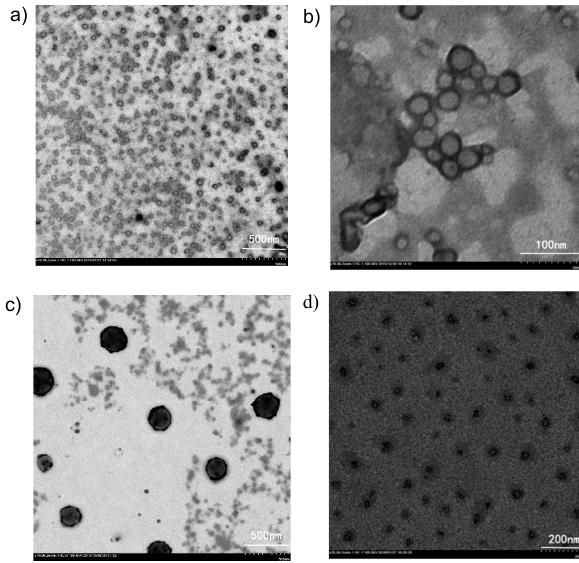
Figure 6. TEM images of self-assembled nanoparticles formed by PS-Se-1- b -PEGMA ( M n,SEC = 3700 g mol − 1 , Ð = 1.11, 1 × 10 − 4 M) at ( a ) × 10.0 k and ( b ) × 70.0 k magnification. TEM images of nanoparticles 5 h after adding H 2 O 2 solution at ( c ) × 10.0 k and ( d ) × 25.0 k magnification.